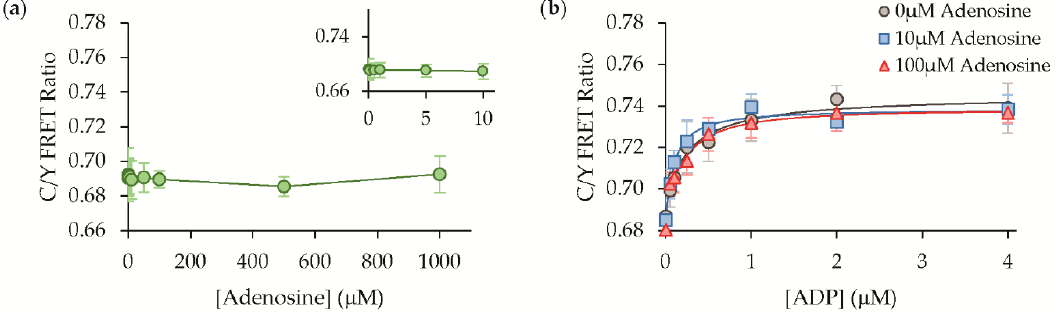
Figure 7. Adenosine binding and interference. ( a ) The sensor does not exhibit a direct response to adenosine, and ( b ) adenosine does not affect the sensor response to ADP in solution studies, mean ± std (n = 3).